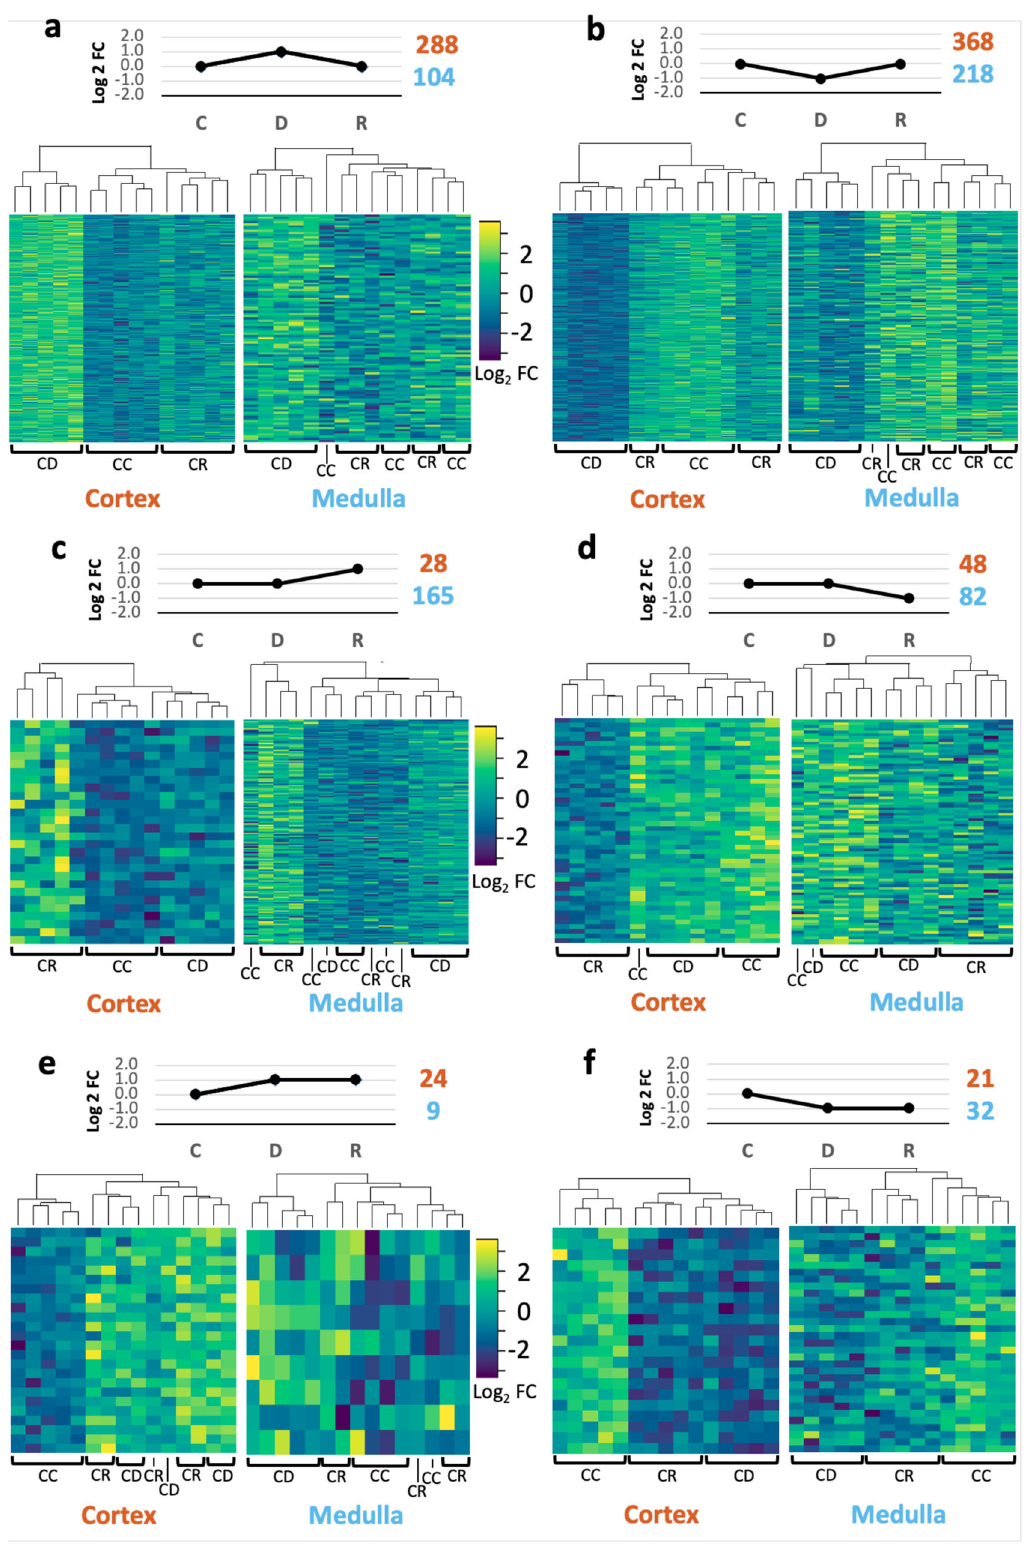
Supplementary Data 7). Similarly, in the medulla, 19 and 50 genes were differentially expressed at both the transcript and the pro- tein level during dehydration and rehydration, respectively (Fig. 4c, d and Supplementary Data 7). While transcriptomic analyses are more sensitive, only highly expressed genes were detectable at protein level by mass spectrometry